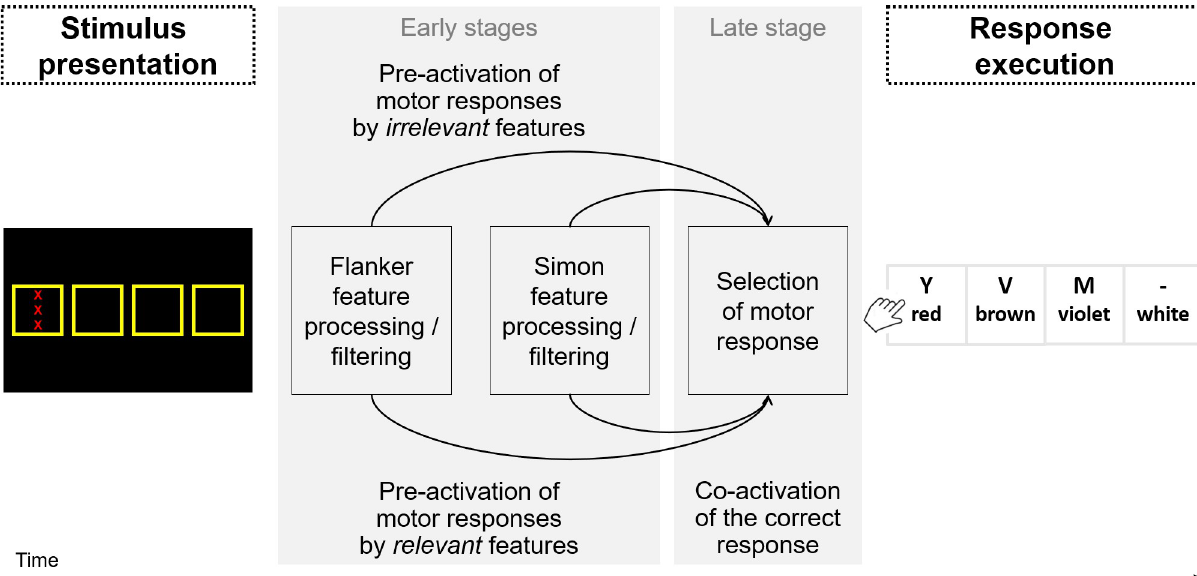
Fig 10. An illustration of how multiplicative priming can be integrated with the different temporal conflict processing observed in the Simon and flanker tasks. The figure presents the case when the trials are both flanker and Simon congruent. Thus, the flanker features are first processed, pre- activating the correct response. Then, the Simon features are processed, pre-activating the correct response again. As a consequence, at the stage of response selection, the correct response is co-activated, facilitating its selection. This impacts the duration of response selection or response execution, and accordingly